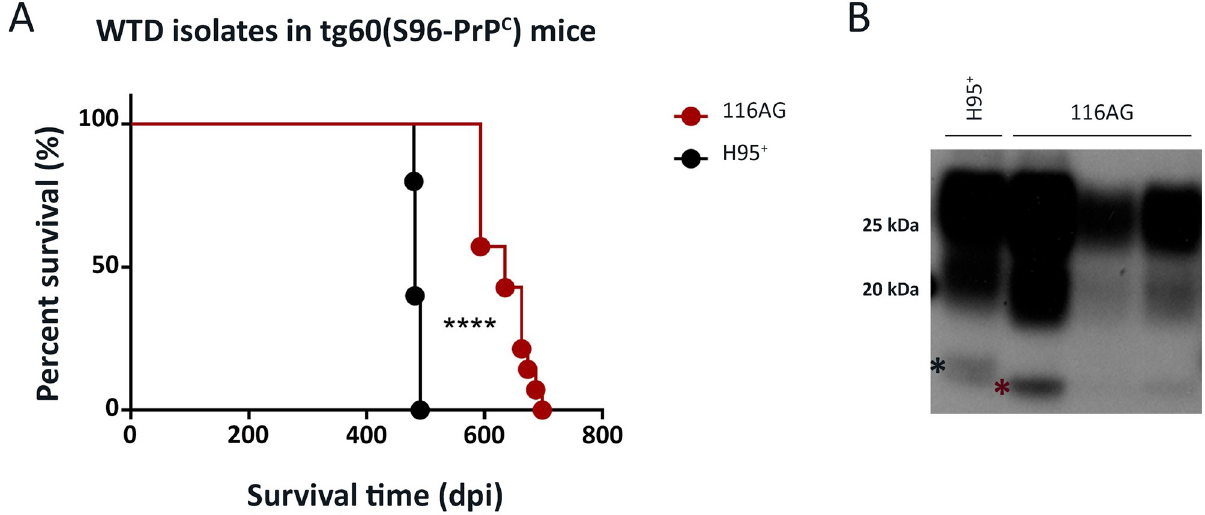
Fig 2. Transmission of the 116AG isolate to transgenic tg60 mice expressing S96-deer PrP. Tg60 mice, expressing S96-deer PrP at 0.7fold, were inoculated with 20 ul of 1% (w/v) brain homogenate containing 116AG or H95 + prions. (A) A Kaplan-Meier curve depicting the survival times of tg60 mice inoculated with 116AG or H95 + strains. ���� p < 0.0001, statistical differences were evaluated using a log-rank (Mantel-Cox) test. (B) Western blot of brain homogenates from mice inoculated with, H95 + (lane 1) or 116AG (lanes 2–4) prions after PK digestion. PrP res was detected using the anti- prion monoclonal antibody BAR224. The asterisks show the migration profile, slow (black asterisk) and rapid (red asterisk), of the non-glycosylated bands.